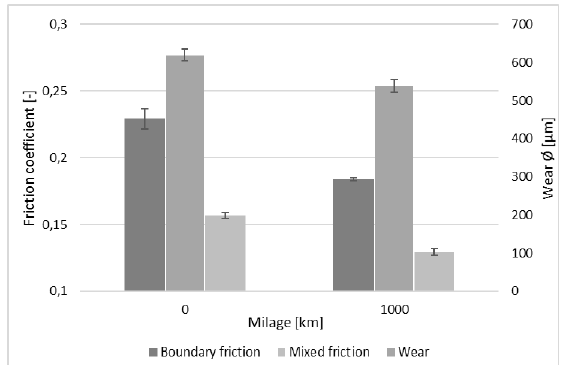
Figure 7: Friction coefficient represented as a function of the diameter of wear and milage In case of the balls, we used 100x200 objective zoom, in case of the discs 100x100 zoom was used to create photos.